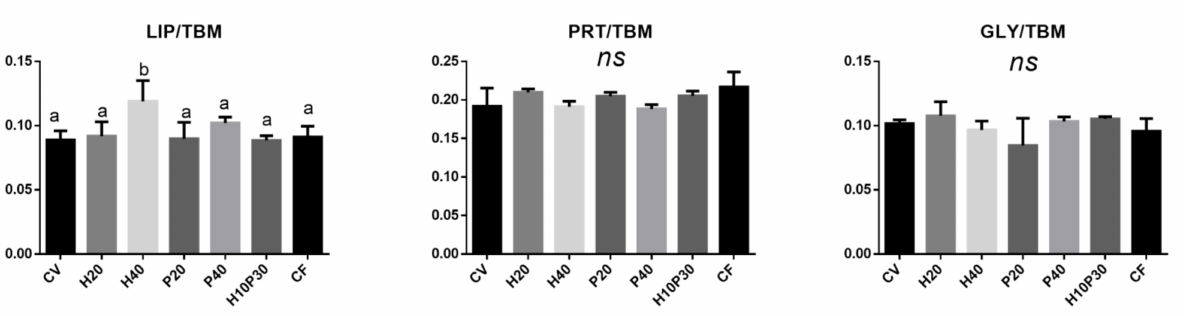
Figure 8. Biochemical composition of liver. Statistical analysis of the following band area ratios: LIP/TBM (relative amount of total lipids), PRT/TBM (relative amount of total proteins), and GLY/TBM (relative amount of